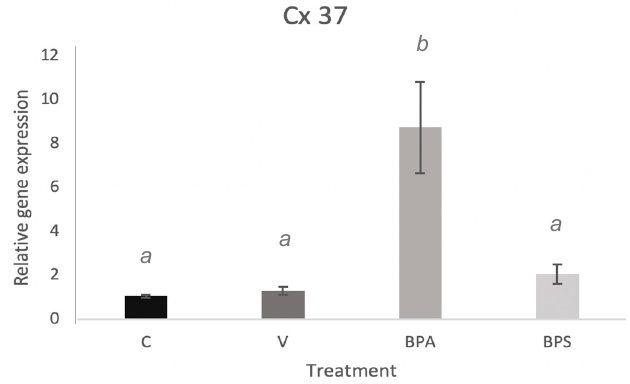
Figure 7. Connexin mRNA expression in bovine cumulus cells. Quantification of Cx37 mRNA after 24 h treatment in the four experimental groups: control, vehicle of 0.1% ethanol, 0.05 mg/mL BPA in 0.1% ethanol and 0.05 mg/mL BPS in 0.1% ethanol. Letters indicates statistical significance at p < 0.05, BPA ( p < 0.001, n = 4).